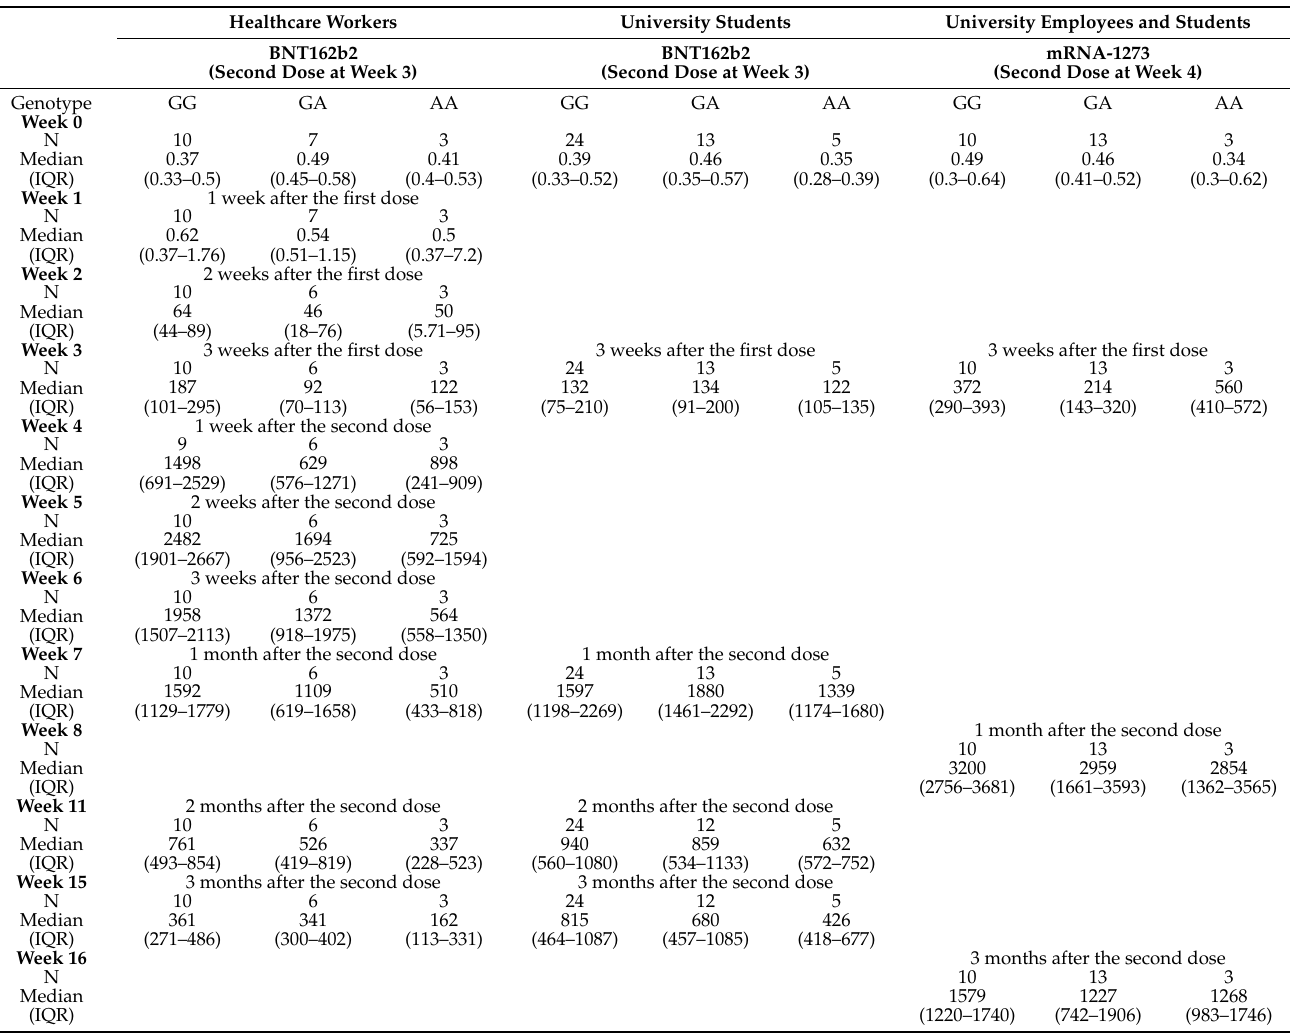
Table 2. Anti-S1 IgG levels (BAU/mL) according to ALDH2 rs671